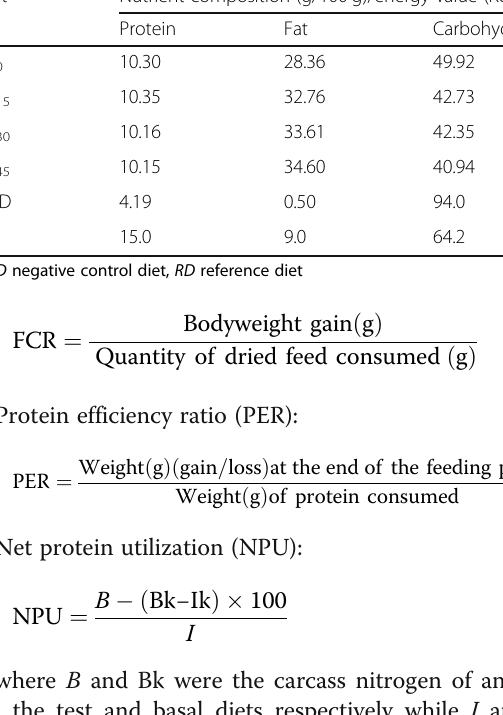
Table 2 Proximate composition and energy values of experimental diets Diet